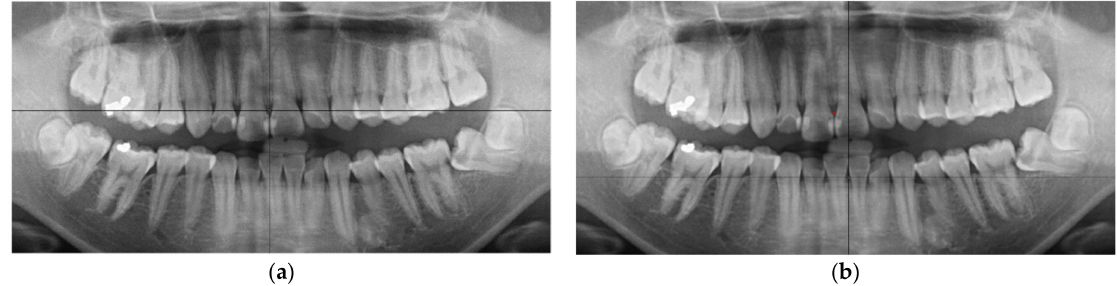
Figure 20. ( a ) Taking the center of the upper row of teeth and ( b ) the center of the bottom row of